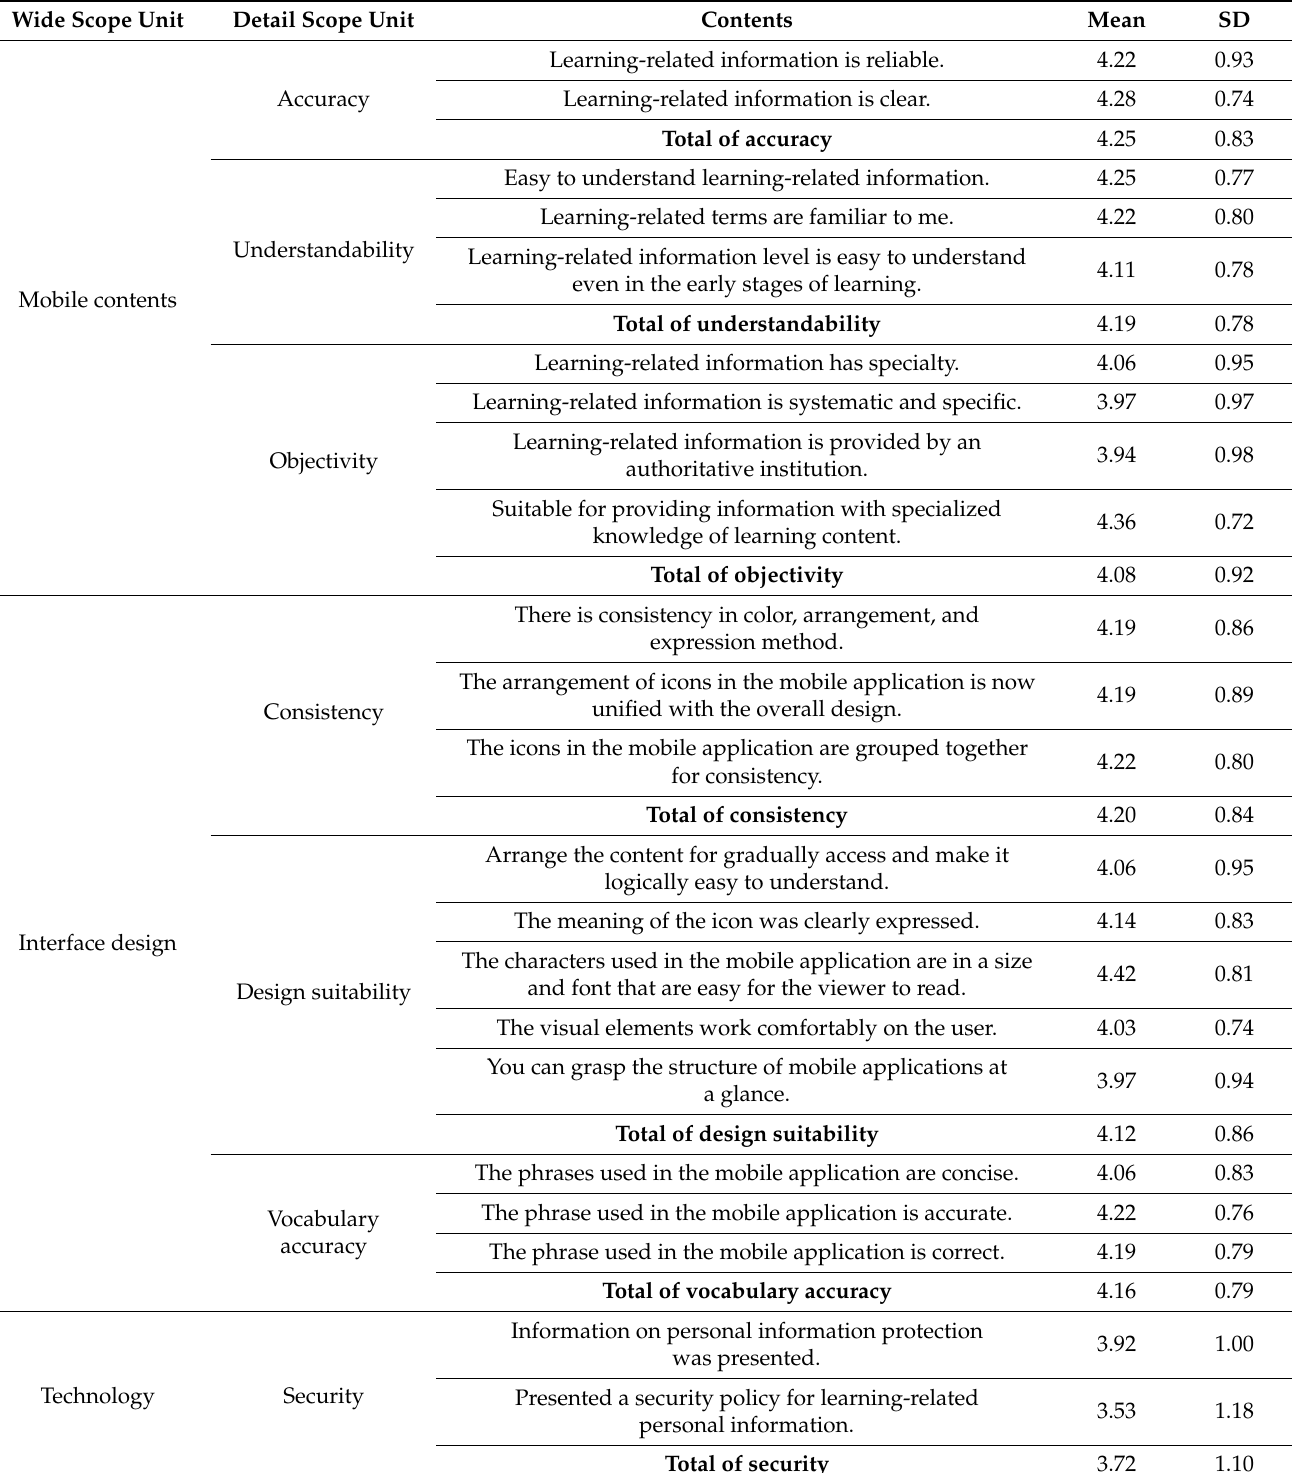
Table 4. Students’ mobile application feasibility